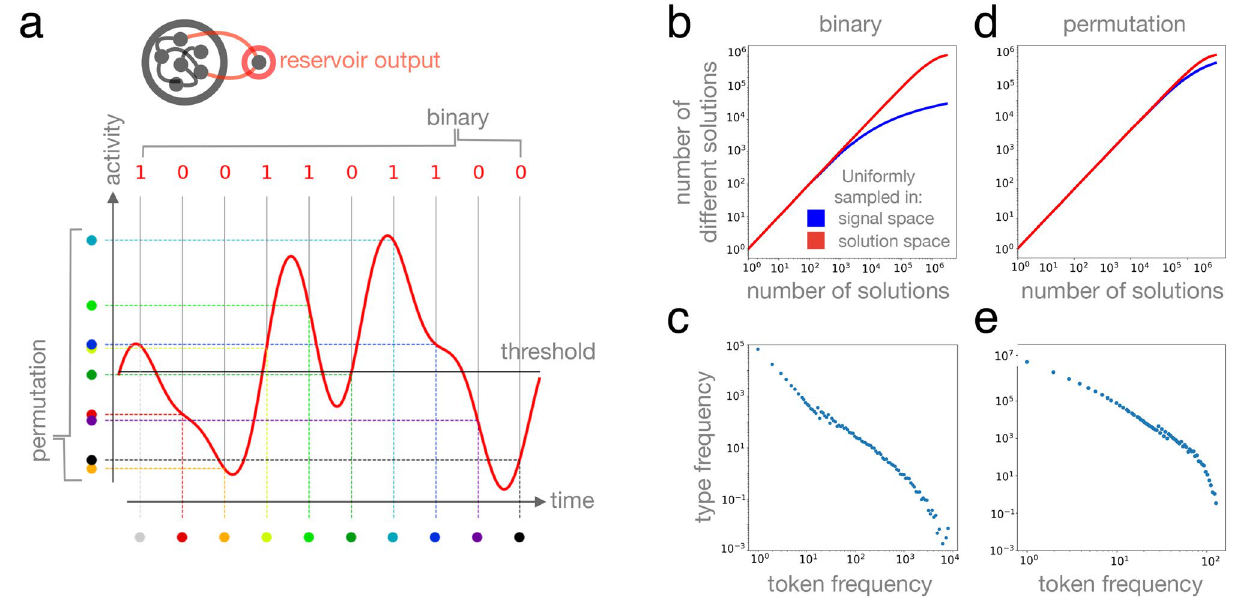
Figure 2. Signal to solution maps and their statistical properties. ( a ) Output signals of reservoirs, shown in red, are mapped to (i) binary sequences by thresholding signal amplitude (i.e., neural activity) at regular time intervals (top), or to permutations by ordering these signal amplitudes. ( b – e ) Statistical representation bias of signal to solution maps, showing that a few solutions are represented by many signals, while most solutions are represented by only a few signals. ( b , d ) Number of different solutions as a function of the number of sampled solutions. Samples are drawn uniformly in signal space (blue; see “Materials and methods” for details), or in solution space (red). While uniform sampling in solution space saturates exponentially, uniform sampling in signal space leads to a different saturation curve as an effect of some solutions being sampled many times while others are sampled less or not at all. ( c , e ) Number of different solutions (types, y axis) with a given sampled frequency (token frequency, x axis), mirroring representation